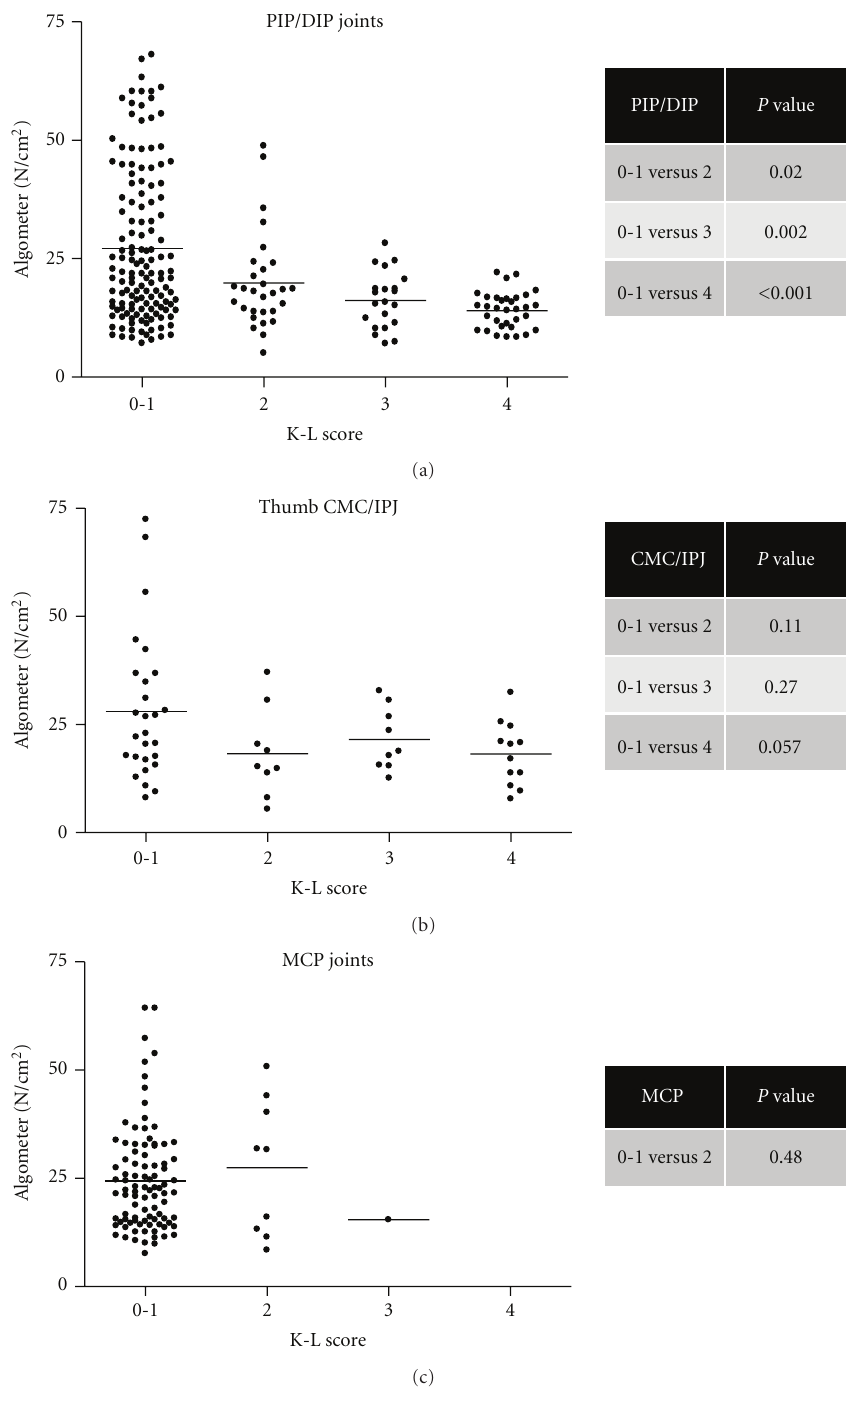
Figure 4: Comparison of pain pressure thresholds by algometer testing with Kellgren-Lawrence score by joint distribution in the hand OA cohort. Algometer versus K-L scores are also shown in DIP/PIP joints (a), thumb IP joints (b), and MCP joints (c). Di ff erences between groups were analysed using an unpaired t -test (significance considered at P ≤ 0 .